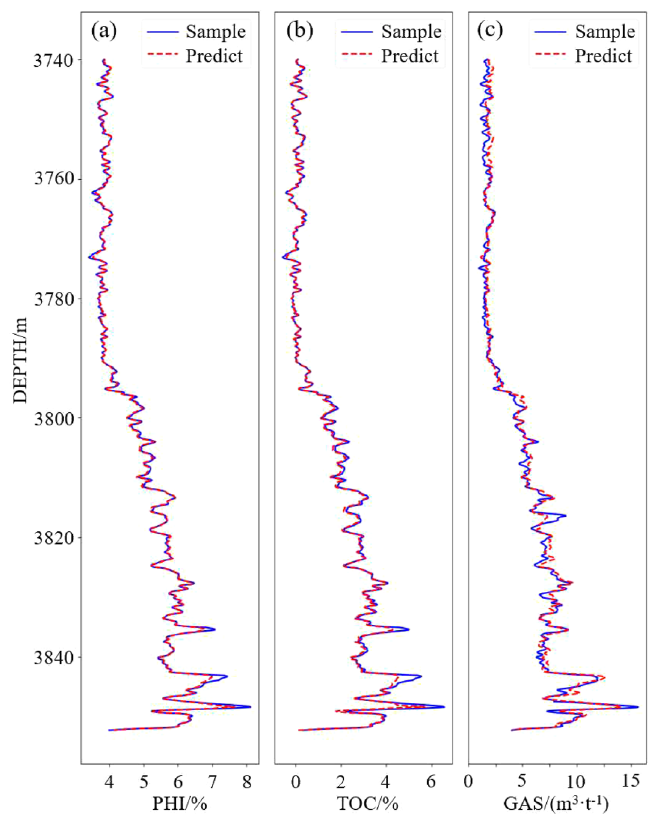
Figure 9. Comparison of predictions and samples of well